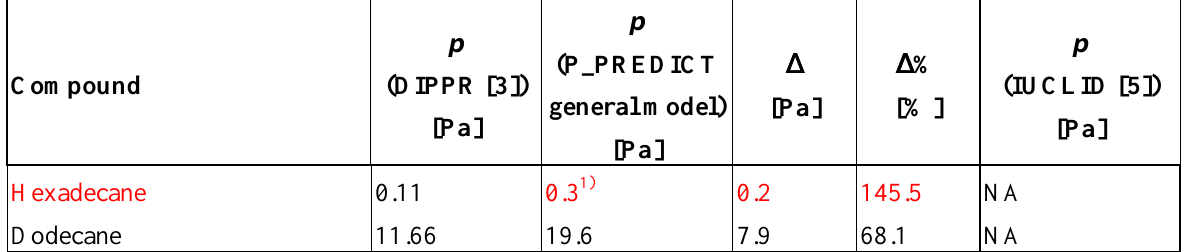
Table 6. P_PREDICT predictions versus “true” vapour pressure values for some hydrocarbons